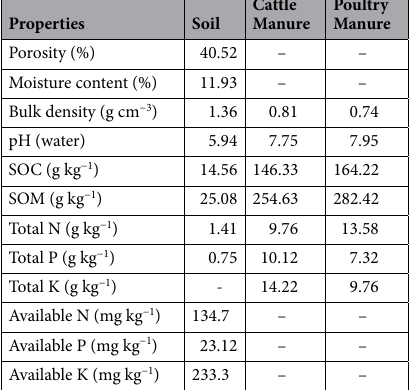
Cattle Poultry Manure Manure